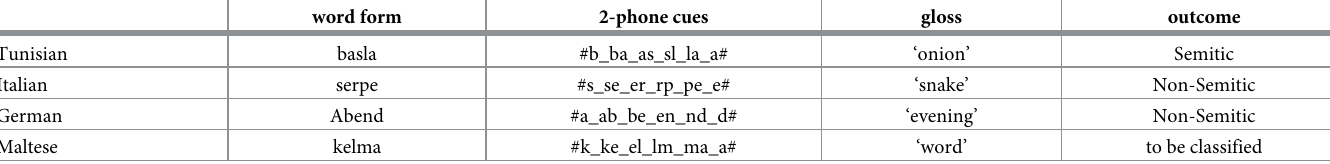
Table 1. Examples for cue-to-outcome structure for all languages. Rows 1-3 represent the training data, row 4 illustrates the Maltese test data with Semitic being the correctly classified